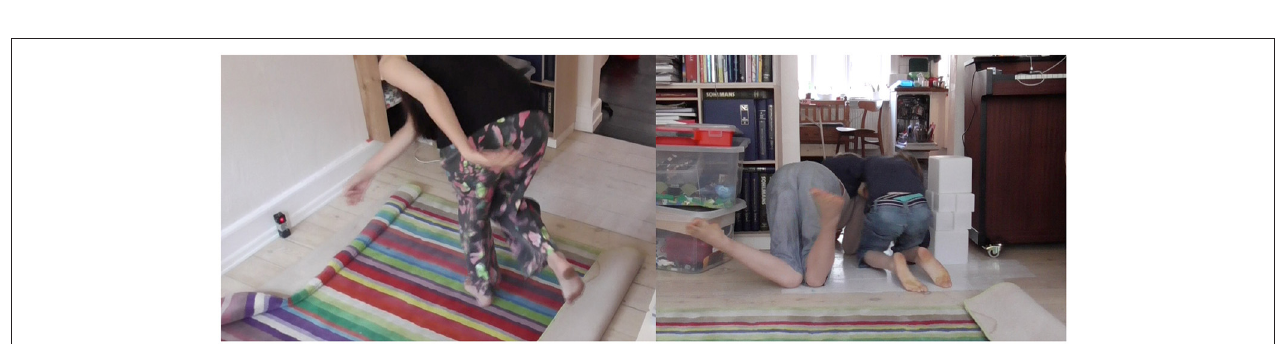
FIGURE 7 | Getting through the laser field; on the left; a mom is forcing the laser field with one foot off the floor, and the two children, in the picture on the right side, are getting under a laser line glued together (the laser pointer and sensor are not in the picture).